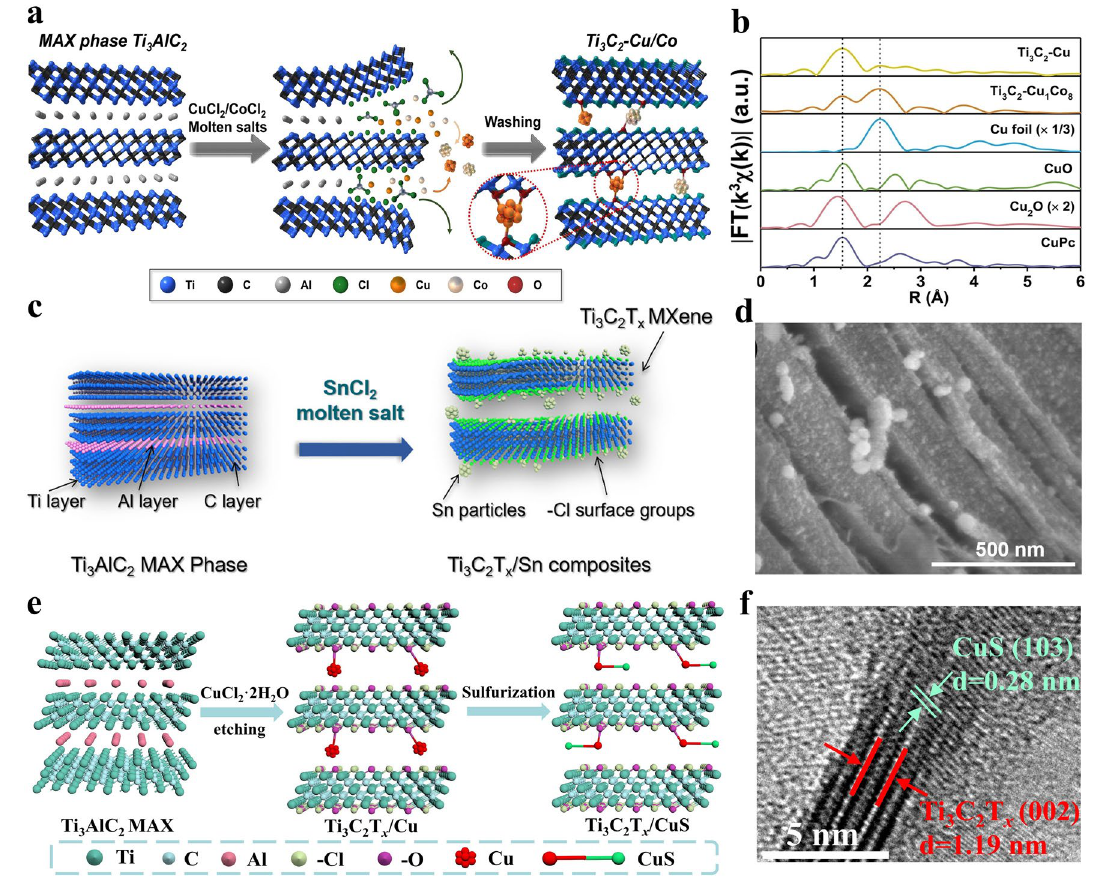
Fig. 8 a Schematic illustration of the synthesis of Ti 3 C 2 -Cu/Co composites. b XAS spectra of Ti 3 C 2 -Cu hybrids. Reproduced with permission from [122] Copyright 2021, Wiley–VCH. c Schematic showing the preparation of Ti 3 C 2 T x /Sn composites by SnCl 2 Lewis acidic salt etching. d SEM image of Ti 3 C 2 T x /Sn hybrids. Reproduced with permission from [145] Copyright 2022, Elsevier. e Schematic diagram of the preparation of Ti 3 C 2 T x /CuS composites. f High-resolution transmission electron microscope (HRTEM) image of Ti 3 C 2 T x /CuS. Reproduced with permission from [148] Copyright 2022, Royal Society of